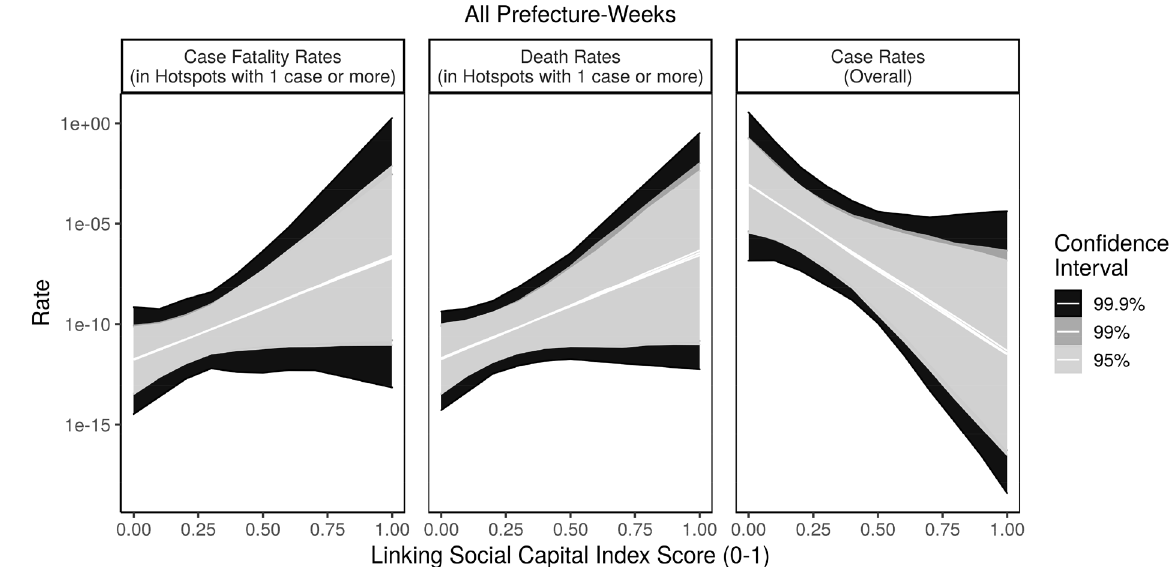
Figure 5. Divergent effects of linking social capital.